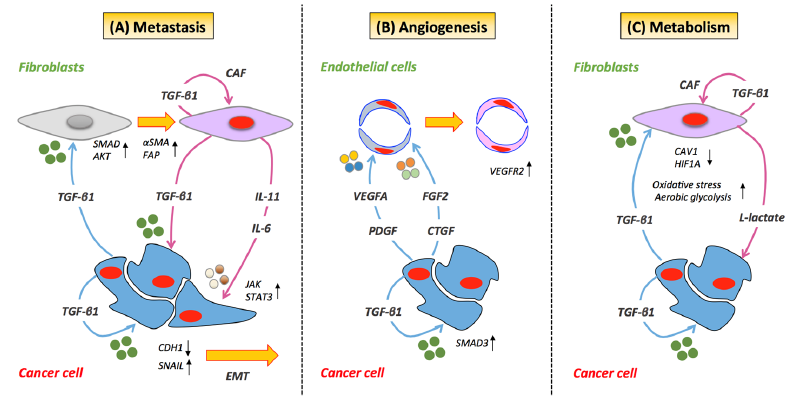
Figure 2. TGF ‐β‐ mediated cancer cell/stromal cell crosstalk. ( A ) TGF ‐β can activate resident stromal Figure 2. TGF- β -mediated cancer cell/stromal cell crosstalk. ( A ) TGF- β can activate resident cells giving rise to cancer ‐ associated fibroblasts (CAFs). In cancer cells, TGF ‐β promotes the transcription of SNAIL, the functional loss of E ‐ cadherin, the acquisition of an EMT phenotype and